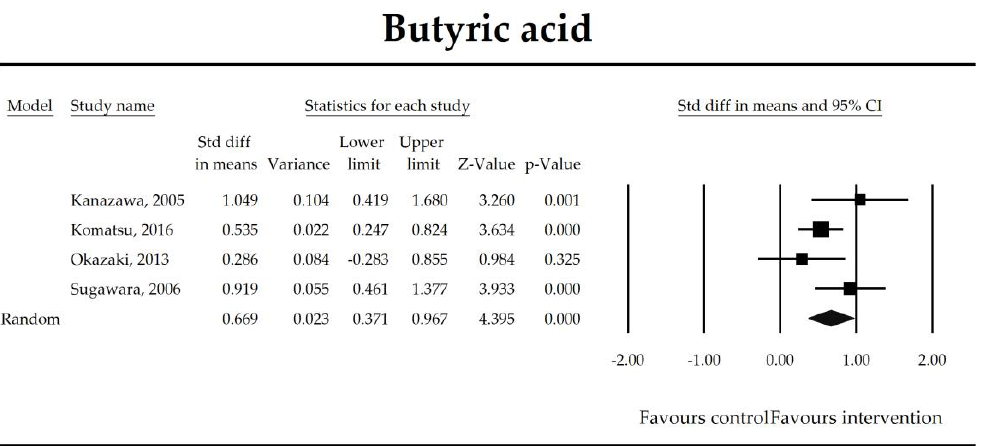
Figure 5. The effect size (standardized mean difference) for the lactulose/mannitol (L/M) ratio in patients taking probiotics (intervention) vs. no probiotics (control).